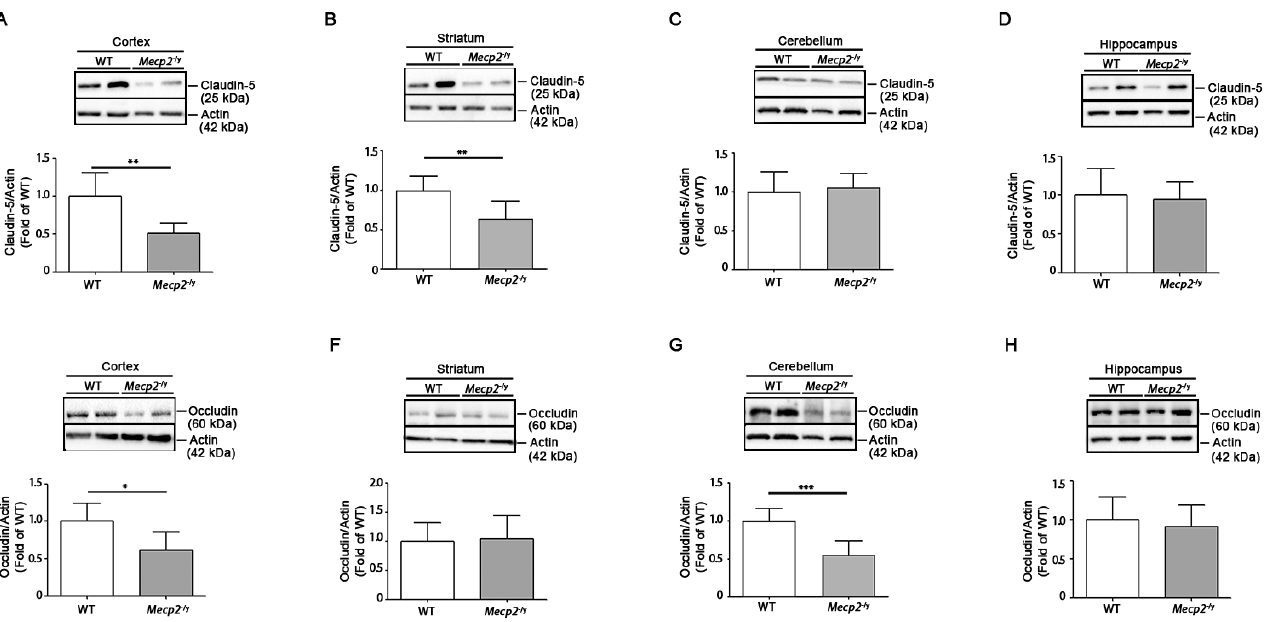
Figure 2. Expression of claudin-5 and occludin proteins is defective in brain tissues of Mecp2 -/y mice. Representative immunoblotting and densitometric analysis of claudin-5 and occludin in cortex ( A , E ), striatum ( B , F ), cerebellum ( C , G ), and hippocampus ( D , H ) of Mecp2 -/y mice and age-matched WT littermates. Actin was used for normalization. Values are represented as mean ± SD. N = 6/7 for each group of mice. *, p < 0.05; **, p < 0.01; ***, p < 0.001 (two-tailed unpaired t -test). Actin blots in ( C , G ) derived from the same gel. Actin blots in ( D , H ) derived from the same gel.